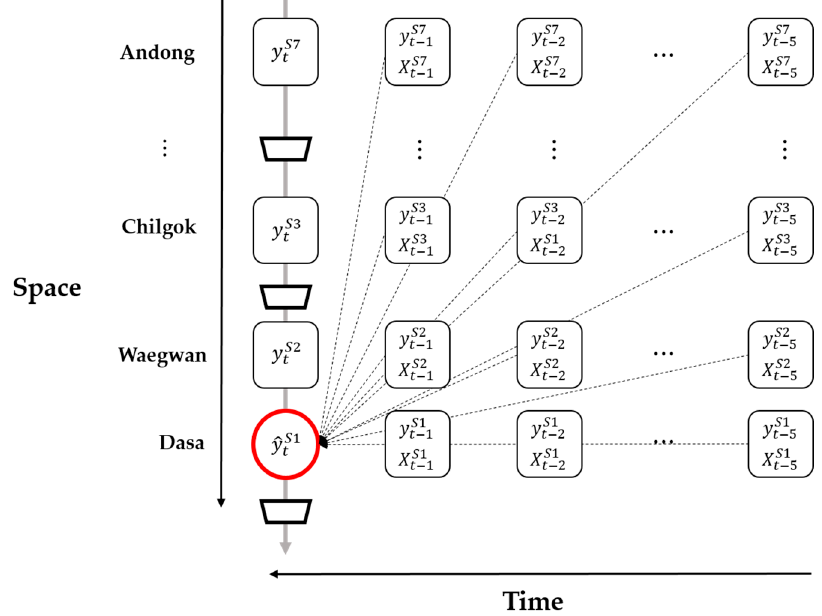
Figure 2. Response variable at time step t at Dasa (ˆ y S 1 t ) and explanatory variables with time–lagged variables by site for predicting the response variable. The dotted arrows denote that the explanatory and time–lagged variables of the identified sites affect the response variable.